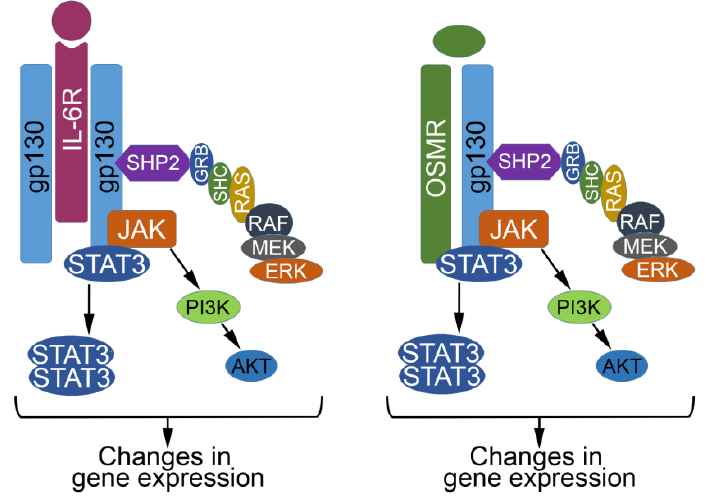
Figure 2. Signaling from the gp130 receptor in response to IL-6 and OSM. In the presence of IL-6 or OSM, Activation of gp130 results in the activation of Signal Transducer and Activator of Transcription 3 (STAT3), and the Mitogen-Activated Protein Kinase (MAPK) and Phosphatidylinositol 3-Kinase (PI3K) signaling cascades as shown. Phosphorylated STAT3 dimerizes, translocates to the nucleus, and promotes transcription of target